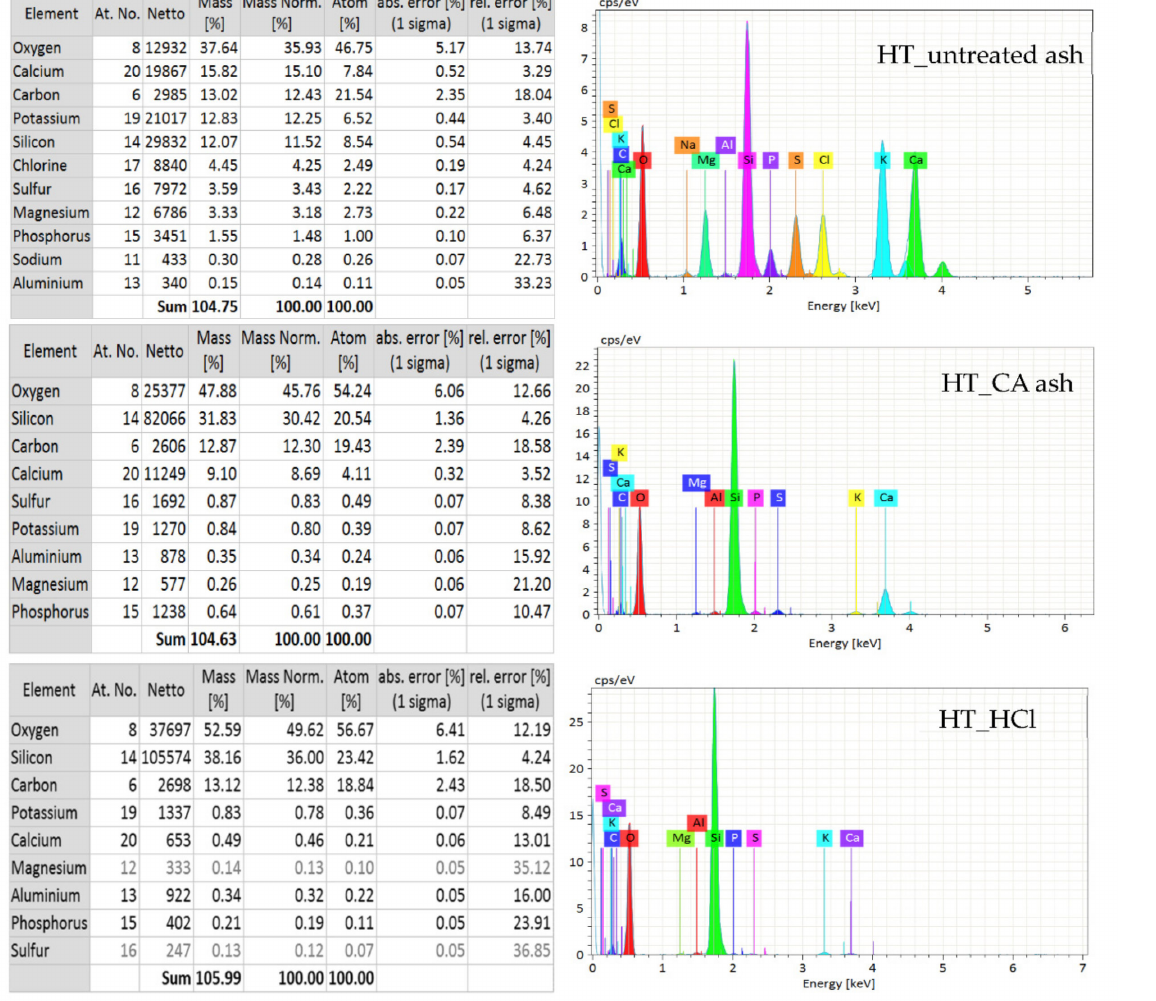
Figure 5. Elemental composition of horsetail